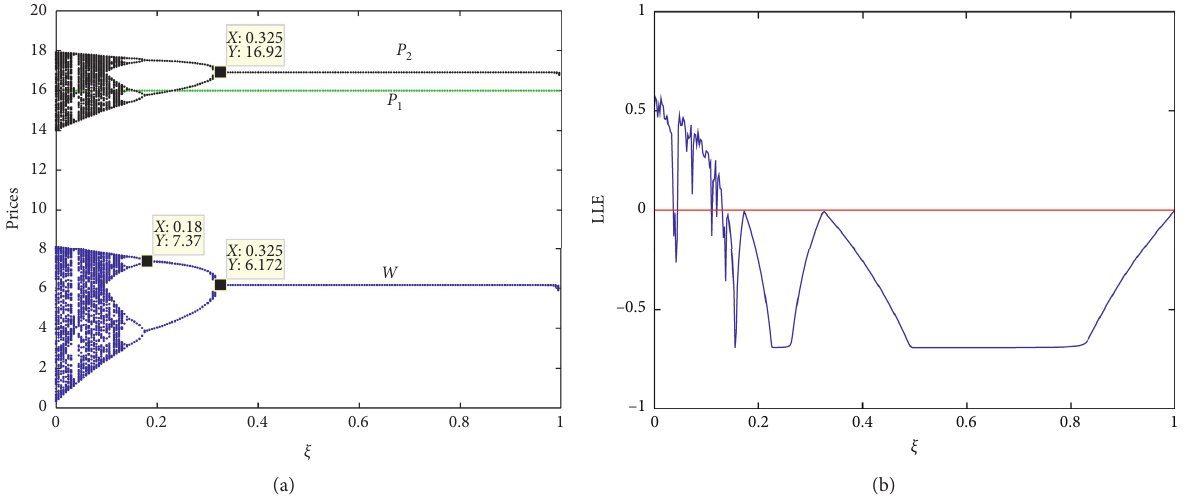
Figure 35: The price evolution process of system (32) with respect to ξ . (a) The bifurcation diagram. (b) The LLE